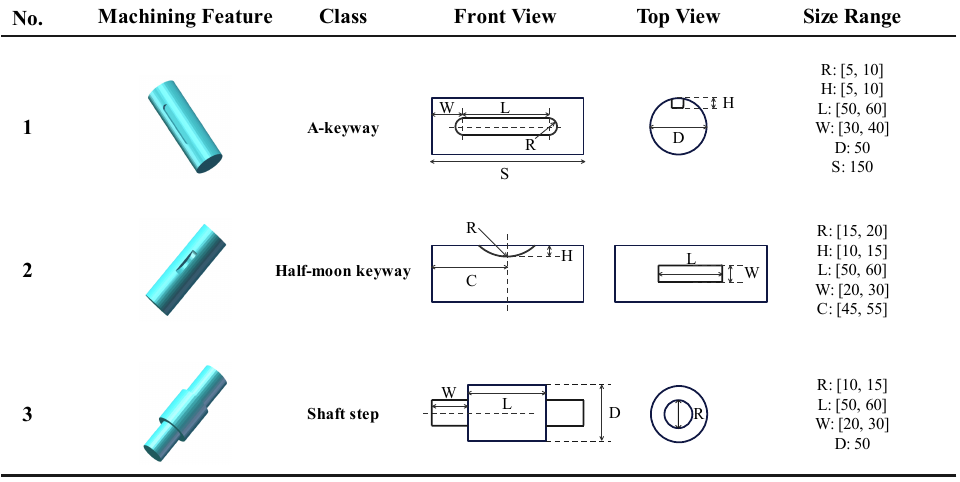
Figure 2. Some rotary machining feature models in MFDataset.